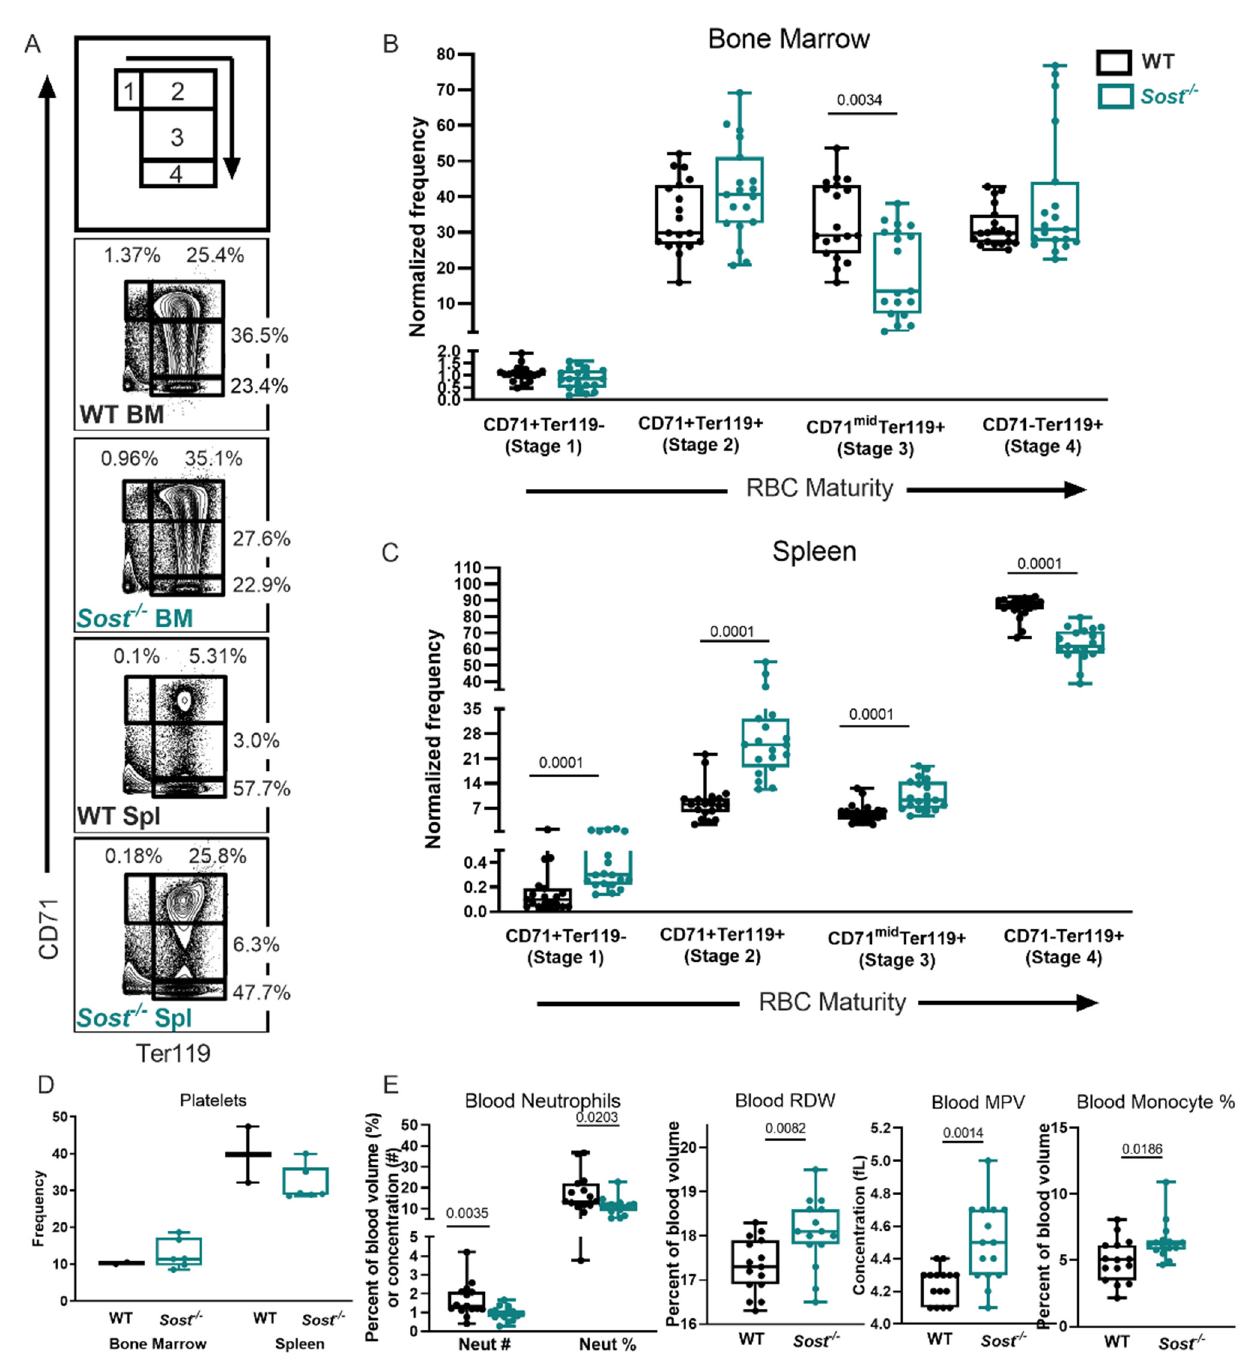
Figure 6. RBC development in the Sost − / − BM is altered and developmentally blocked in the Sost − / − spleen. ( A ) Representative FACS plots depicting stages of RBC development. ( B ) Normalized frequencies of stages 1–4 bone marrow RBC progenitor populations. ( C ) Normalized frequencies of stages 1–4 splenic RBC populations. ( D ) Bone marrow platelet frequency measured by flow cytometry. ( E ) CBC analysis depicting neutrophil concentration and cellularity, red blood cell distribution width (RDW), and mean platelet volume (MPV). Data on RBC development in the BM and spleen of mice were compiled from 3 independent experiments, and male and female mice of 9–60 weeks of age were used. Platelet analyses in the BM and spleen were compiled from 2 independent experiments, using mice of both sexes ranging in age from 6 to 60 weeks. Peripheral blood data were compiled from 2 independent experiments, using mice of both sexes ranging in age from 25 to 48 weeks. The actual p -values are shown, underlined.